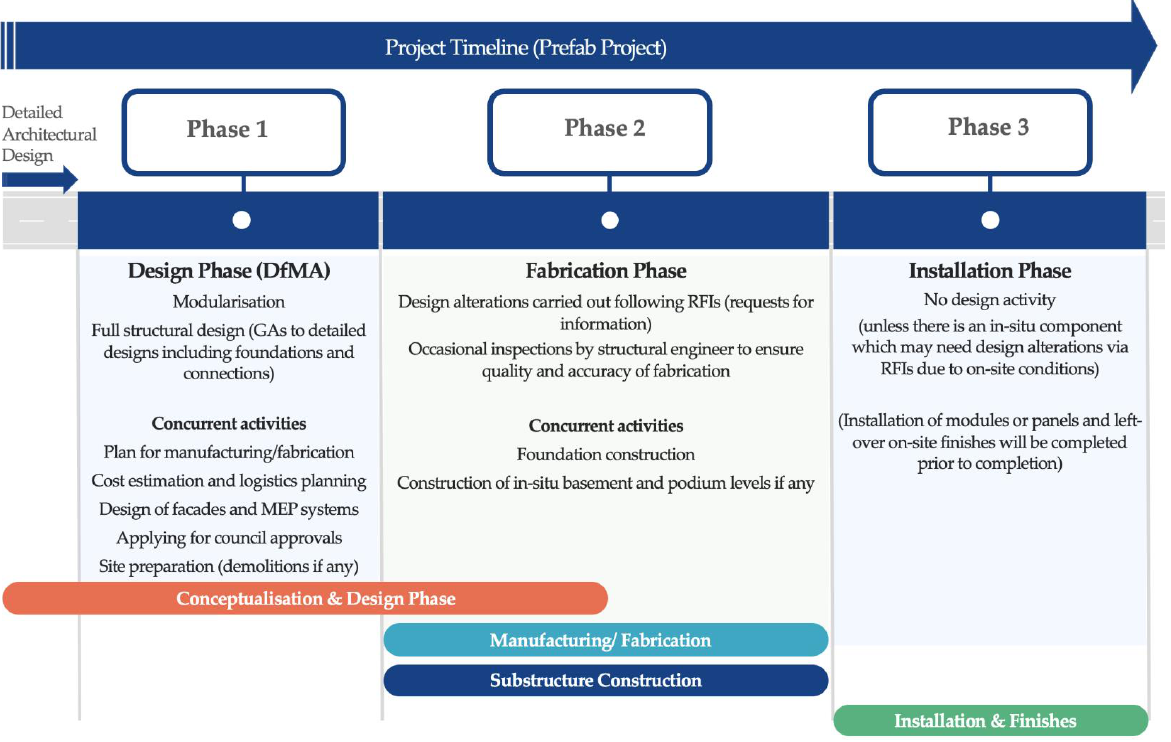
Figure 3. A typical DfMA (Design for Manufacturing and Assembly) process for a prefab construction alongside other related activities that occur concurrently with each phase of the DfMA process.